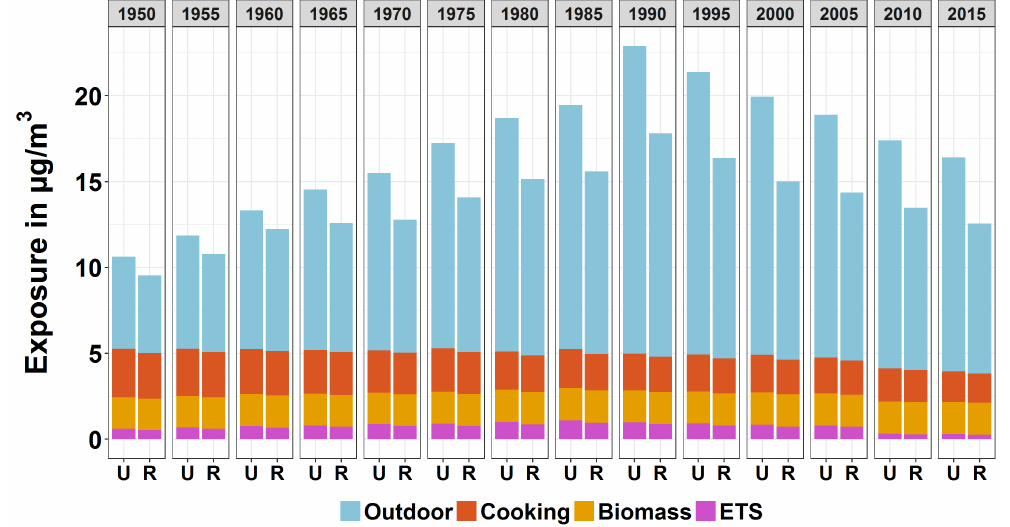
Figure 9. Population-weighted arithmetic mean NO 2 exposure by source and degree of urbanisation for European countries from 1950 to 2015. The “U” stands for “Urban or suburban areas” while the “R” stands for “Rural